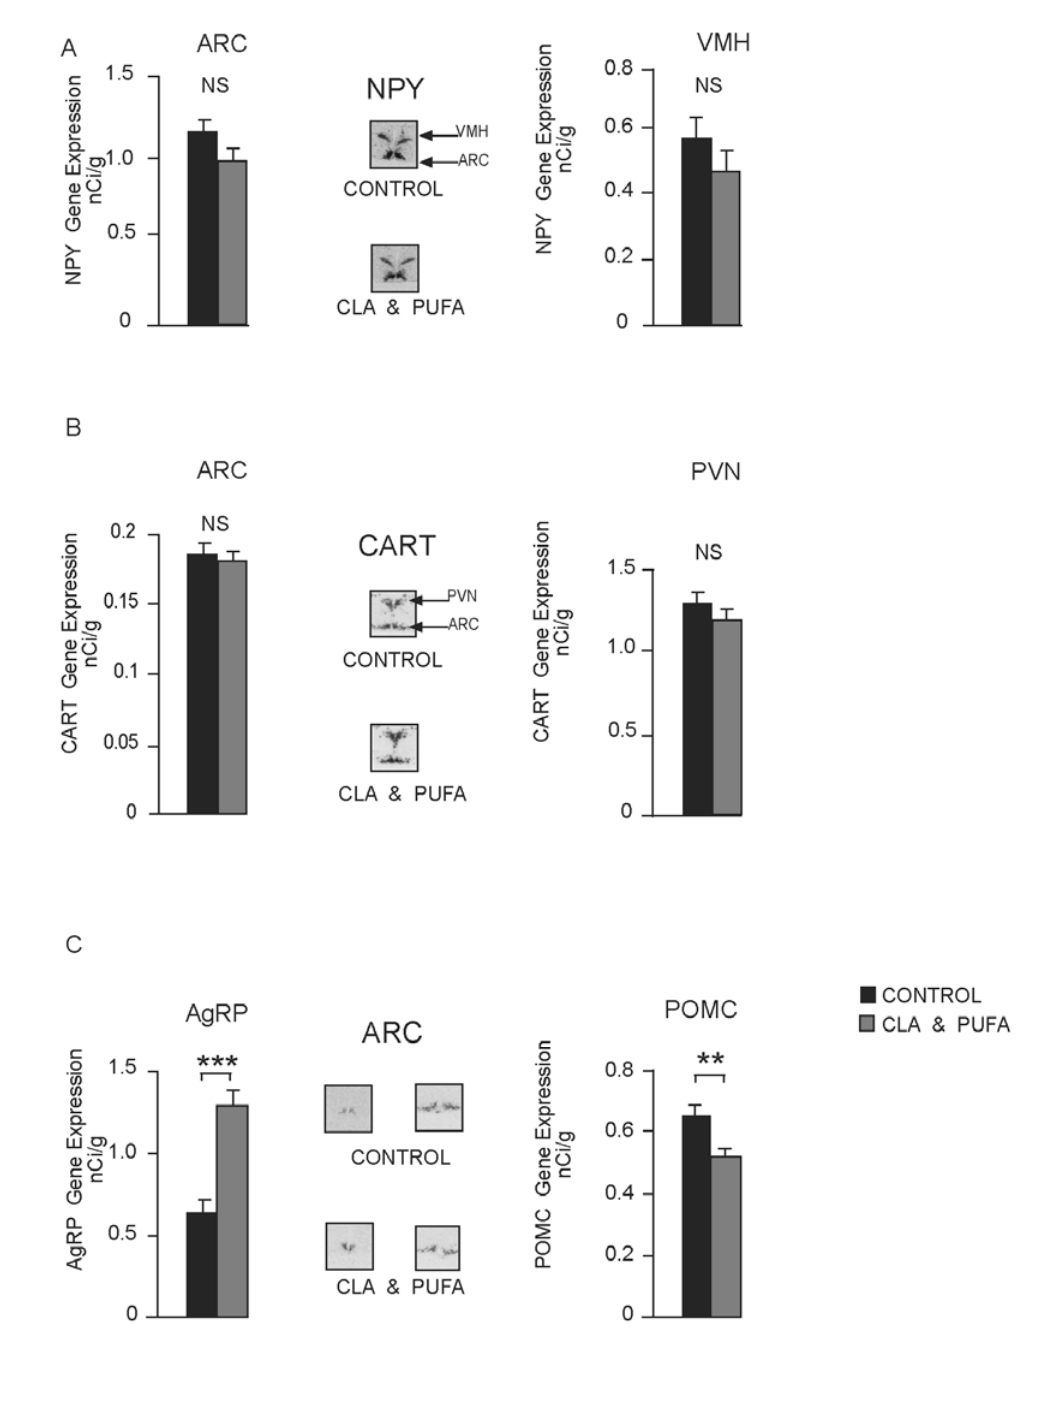
Figure 6. Effect of CLA plus n- 3 LC-PUFA supplementation on hypothalamic peptide gene expression including representative autoradiographs of the hypothalamic regions measured. A. There was no significant (NS) change in NPY or B. CART gene expression in either the arcuate nuclei (ARC), ventromedial nuclei (VMH) or paraventricular nuclei (PVN) after supplementation. C. AgRP gene expression was increased in the arcuate nuclei (ARC), *** P < 0.001 after CLA plus n-3 LC-PUFA supplementation while POMC gene expression was reduced, ** P <